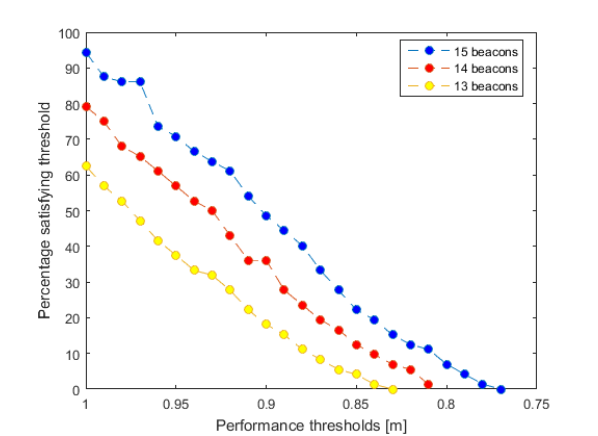
Figure 11. The percentage (%) of the user locations satisfying the thresholds in terms of precision versus the performance thresholds for 15, 14 and 13 available